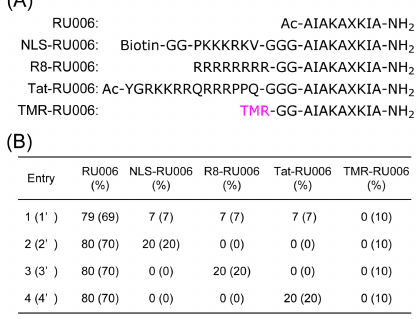
Figure 2. ( A ) Amino acid sequences of RU006 as a carrier peptide; NLS-RU006, R8-RU006, and Tat-RU006 as CPP/NLS moiety-tethering peptides; and TMR-RU006 as a fluorescence tracer; ( B ) The compositions of nanocarriers examined in this study. The compositions of Entries 1’–4’ are in parentheses. Abbreviations: CPP = cell-penetrating peptide; NLS = nuclear localization signal; X = L-2-naphthylalanine; TMR = 5(6)-carboxytetramethylrhodamine.